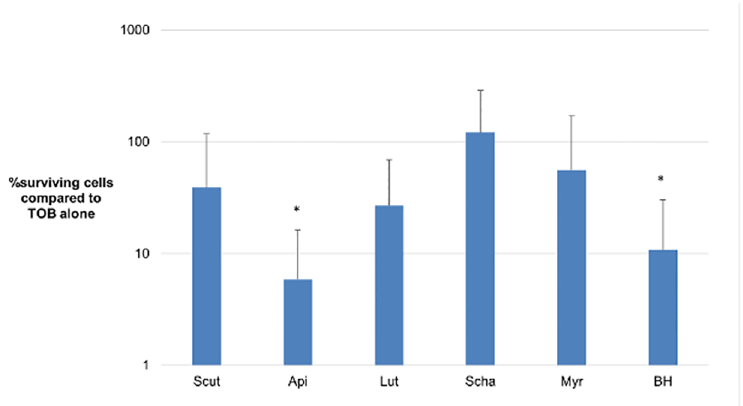
Fig 1. Potentiating effect of BH and other flavonoids. Data shown are percentage survival of B . cenocepacia J2315 biofilm cells treated with the combination of a flavonoid (100 μM) and TOB (4 x MIC) compared to TOB alone. The tested flavonoids were scutellarin (scut), apigenin 7-O-glucoside (api), luteolin 7-O-glucoside (lut), schaftoside (scha), myricitrin (myr) and baicalin hydrate (BH). (cid:3) : statistically significant (p < 0.05) less survival compared to TOB alone. Error bars are standard deviations (SD) (n =